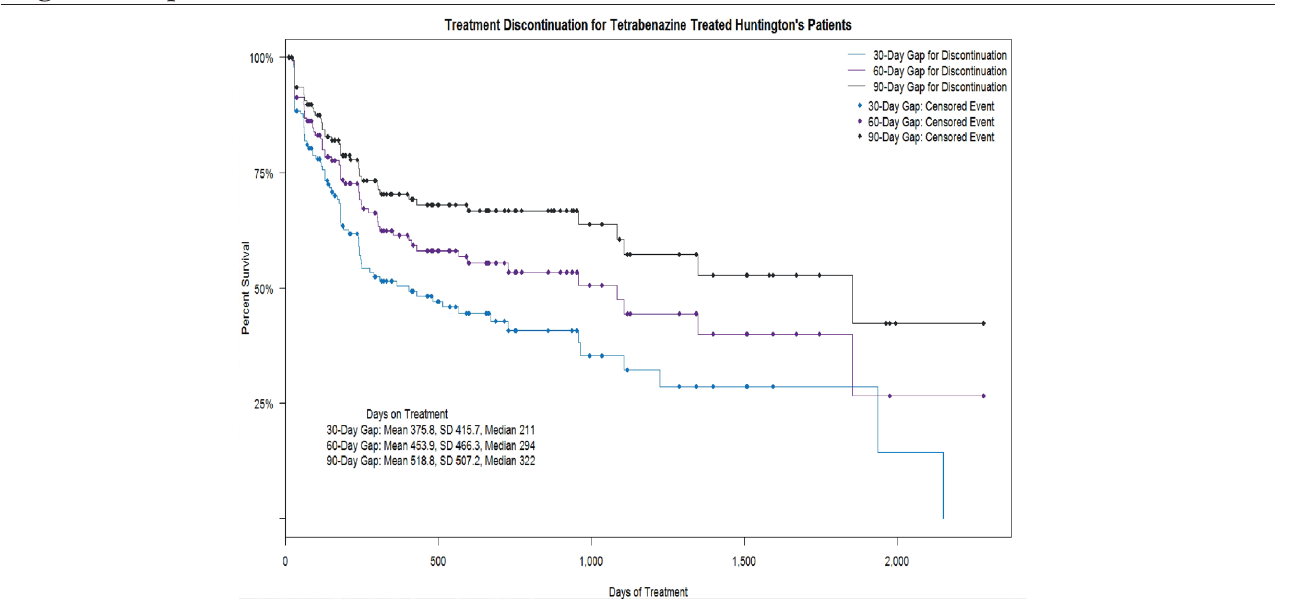
Figure 3. Kaplan–Meier Curve: Time to Tetrabenazine Discontinuation